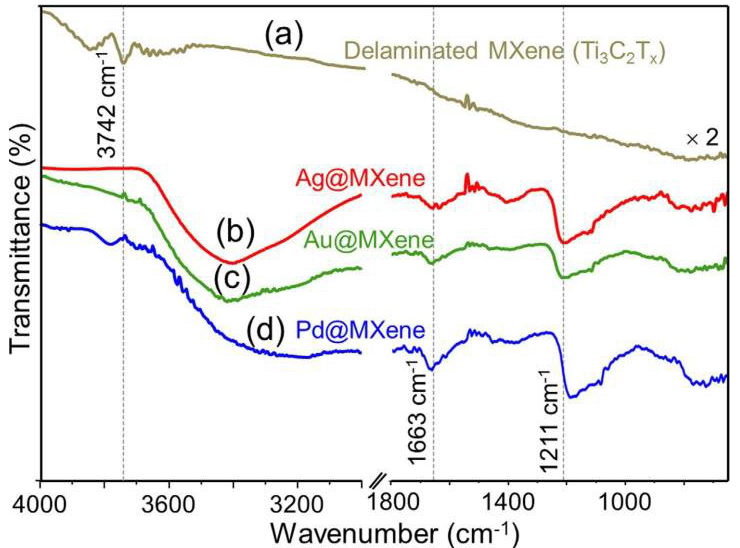
Figure 16. ATR-FTIR spectroscopy analysis of delaminated MXene nanosheets ( a ) (Ti 3 C 2 T x ) and ( b ) Ag@, ( c ) Au@ and ( d ) Pd@MXene hybrids. Reprinted with permission from [70]. Copyright 2016 Springer Nature.